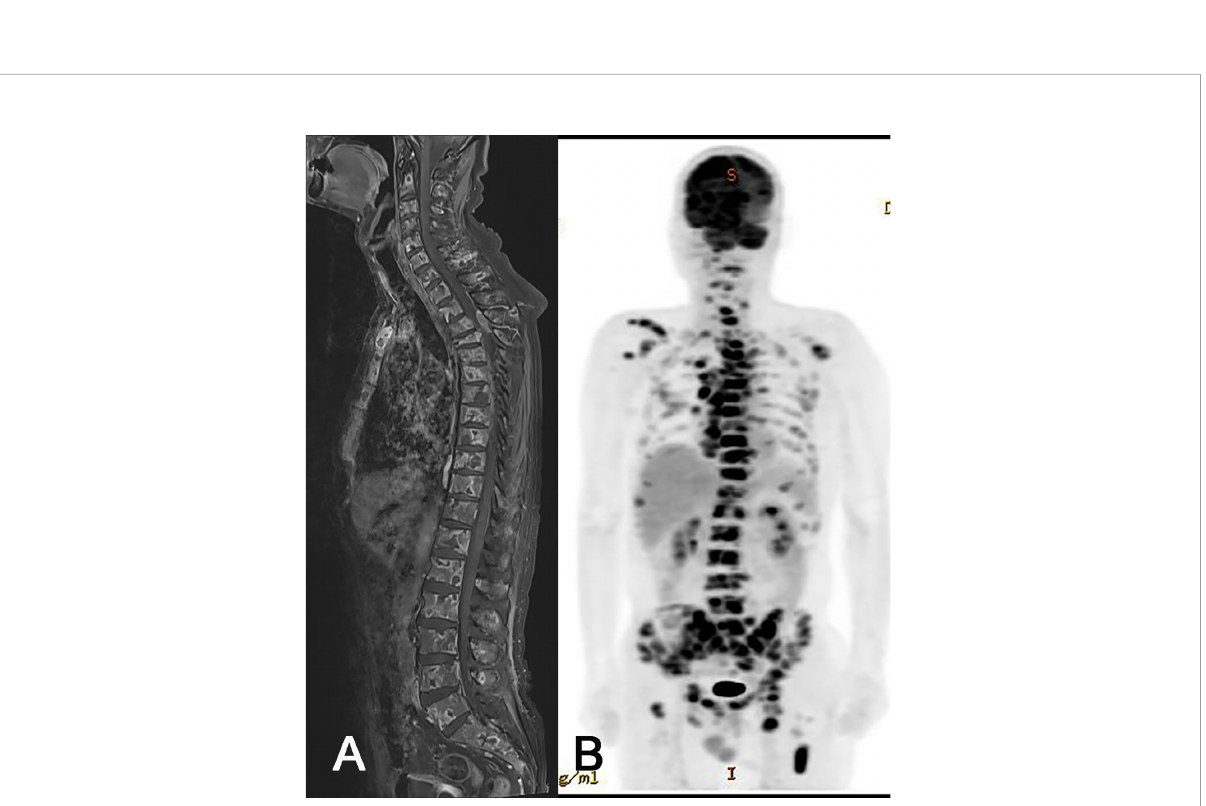
FIGURE 3 Radiologic images of extraneural metastasis (ENM). Whole spine MRI (A) and PET-CT (B) showing extensive ENM to multiple bones and lymph